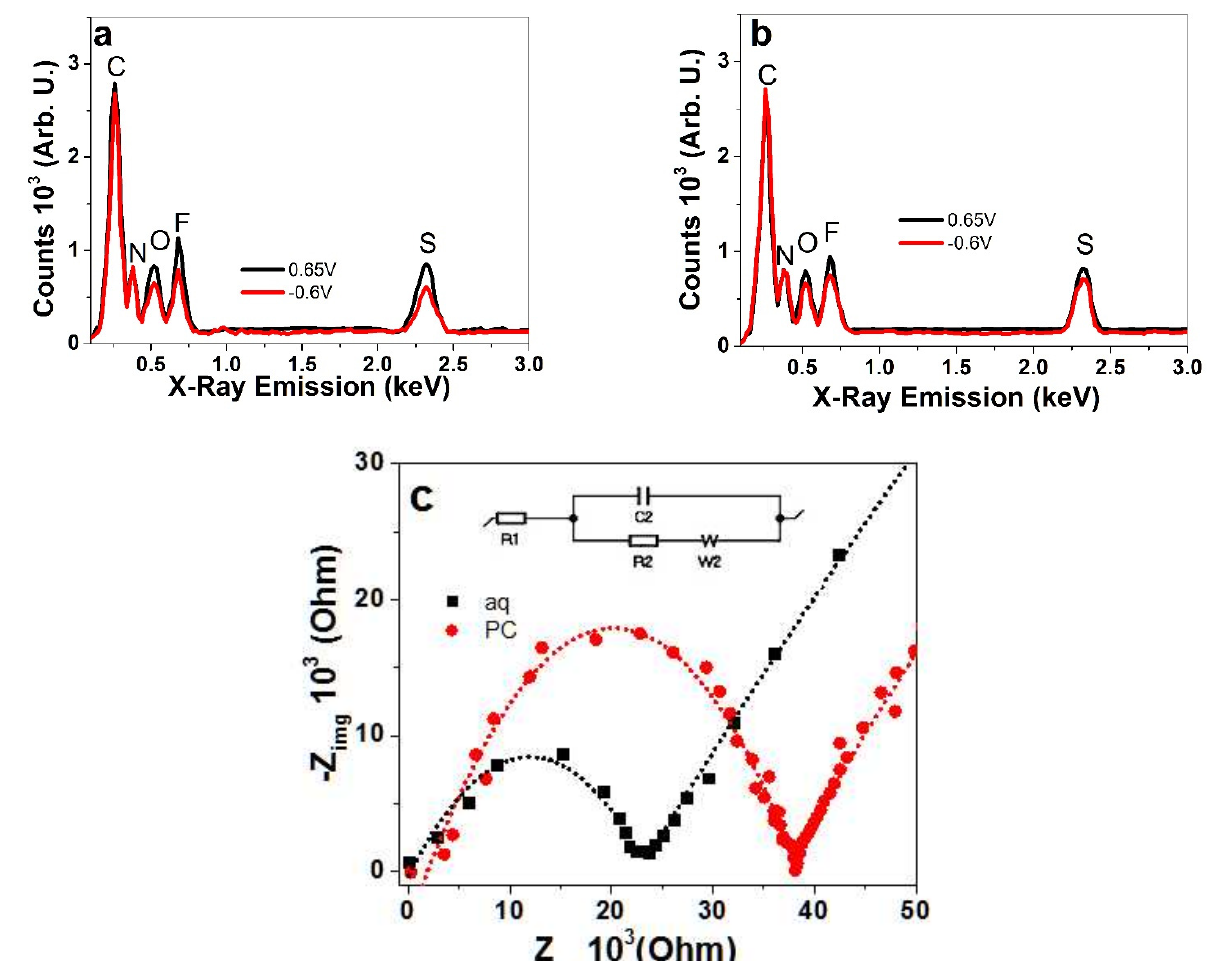
Figure 2. EDX spectroscopy of PIL polymer films at charged (0.65 V, black line) and discharged ( − 0.6 V, red line) state, applied in LiTFSI electrolyte with different solvents, ( a ) LiTFSI-aq and ( b ) LiTFSI-PC. ( c ) EIS Nyquist plots with fitting (dotted curve) (inset Randle’s equivalent circuit, R1: solution resistance, R2: charge transfer resistance, C2: double layer capacitance and W2: Warburg element) of PIL polymer in LiTFSI-aq (aq, ■ ) and LiTFSI-PC (PC, ● ) electrolytes.